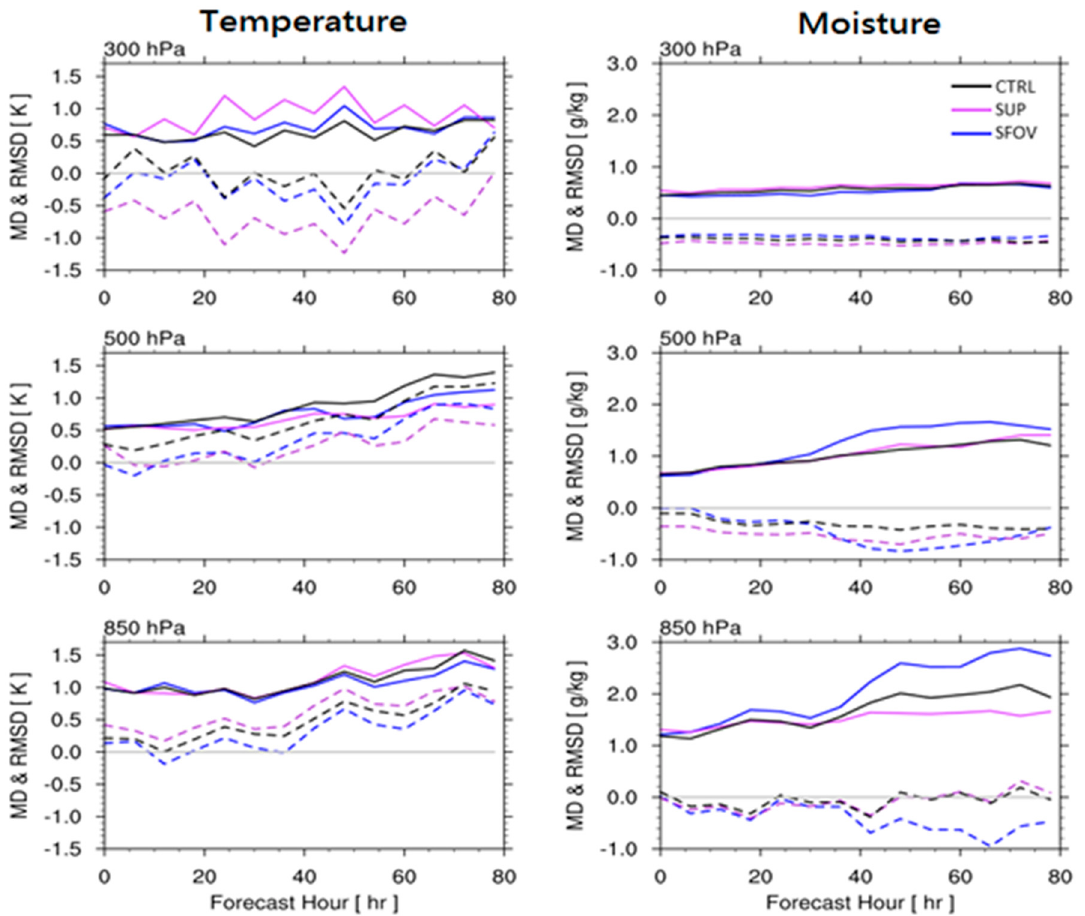
Figure 6. Statistics of forecast performance of temperature ( left column) and moisture ( right column) at 300 ( top row), 500 ( middle row) and 850 hPa ( bottom row) on CTRL ( black curves), SUP ( purple curves) and SFOV ( blue curves) experiments. The solid curves are RMSD, and the dashed curves are MD.